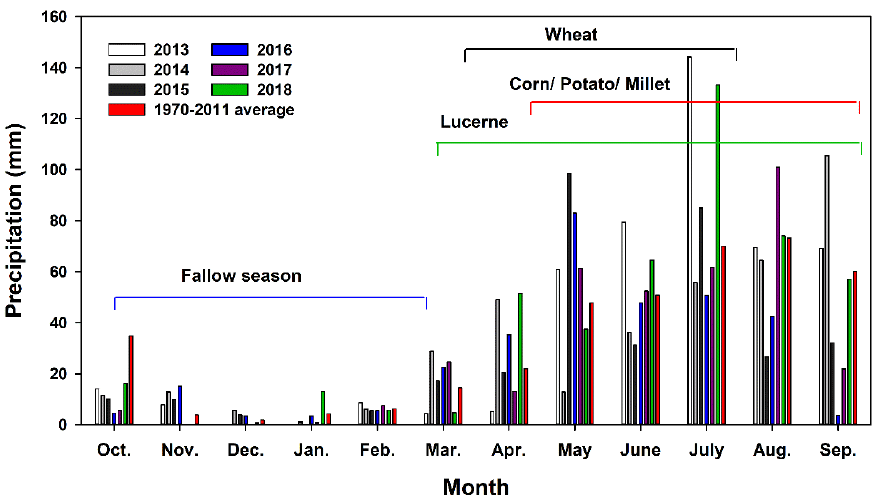
compared to lucerne–lucerne. Crop rotation treatments also affected soil bulk density and porosity (Table 3). With the exception of L-M in the 10–30 cm soil layer, soil bulk density was highest under L-L and lowest under L-M in the 0–50 cm soil layers. In contrast, with the exception of L-M in the 10–30 cm soil layer, total soil porosity was lowest under L-L and highest under L-M in the 0–50 cm soil layers.